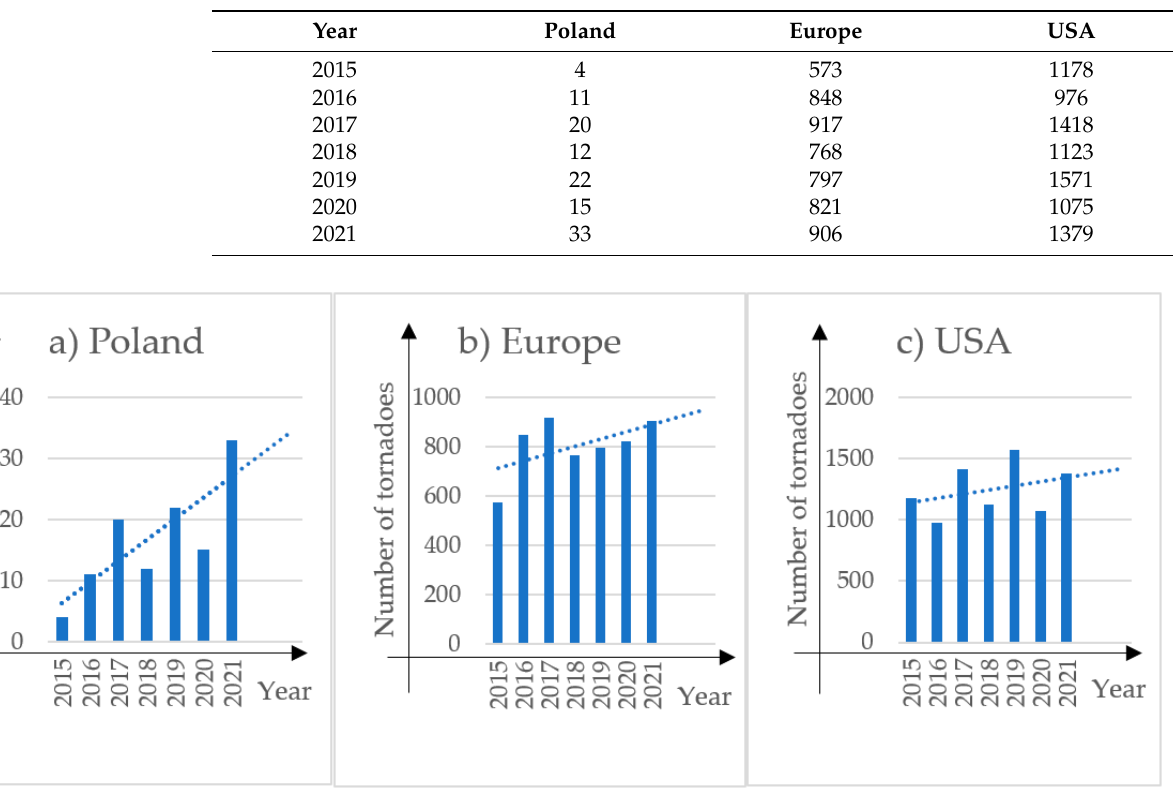
Figure 4. Tornado activity in the USA. Number of recorded EF3, EF4 and EF5 tornadoes per 2470 square miles. [23].